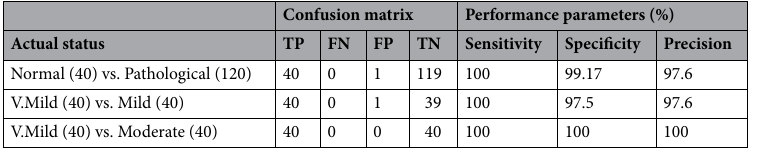
Table 6. performance measures. where, TP true positive, TN true negative, FN false negative, FP false positive.